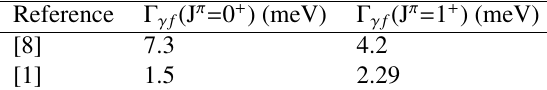
Table 1. Partial widths available in the literature for the two-step fission